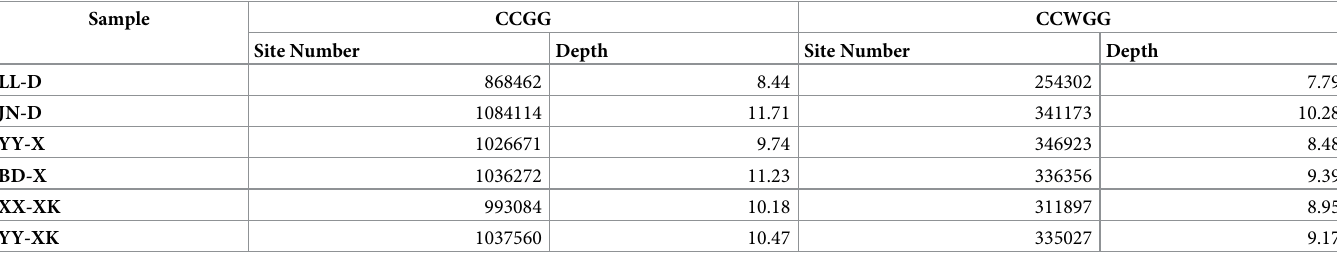
Table 3. Overall methylation site